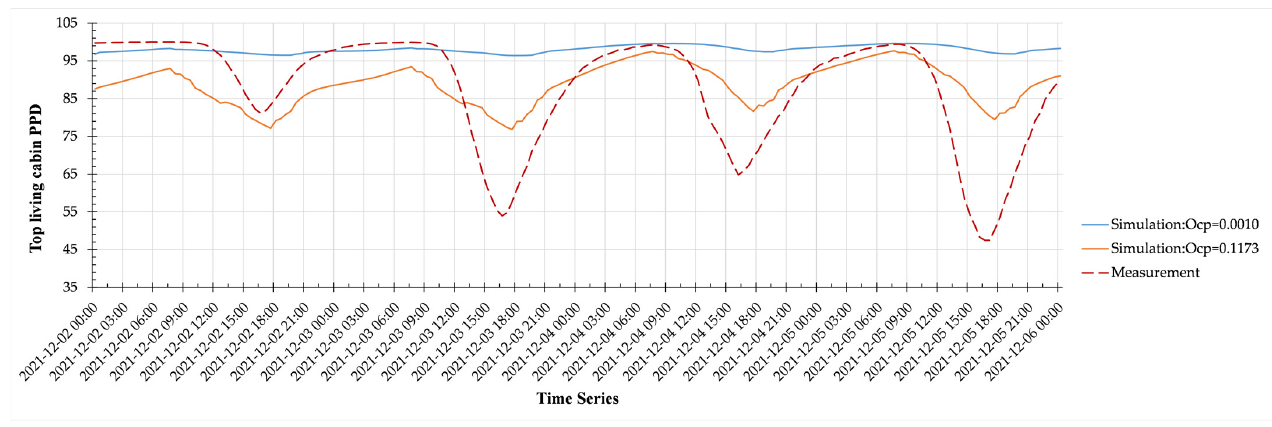
Figure 21. Top living cabin: predicted percentage dissatisfied between 2 and 5 December 2021.